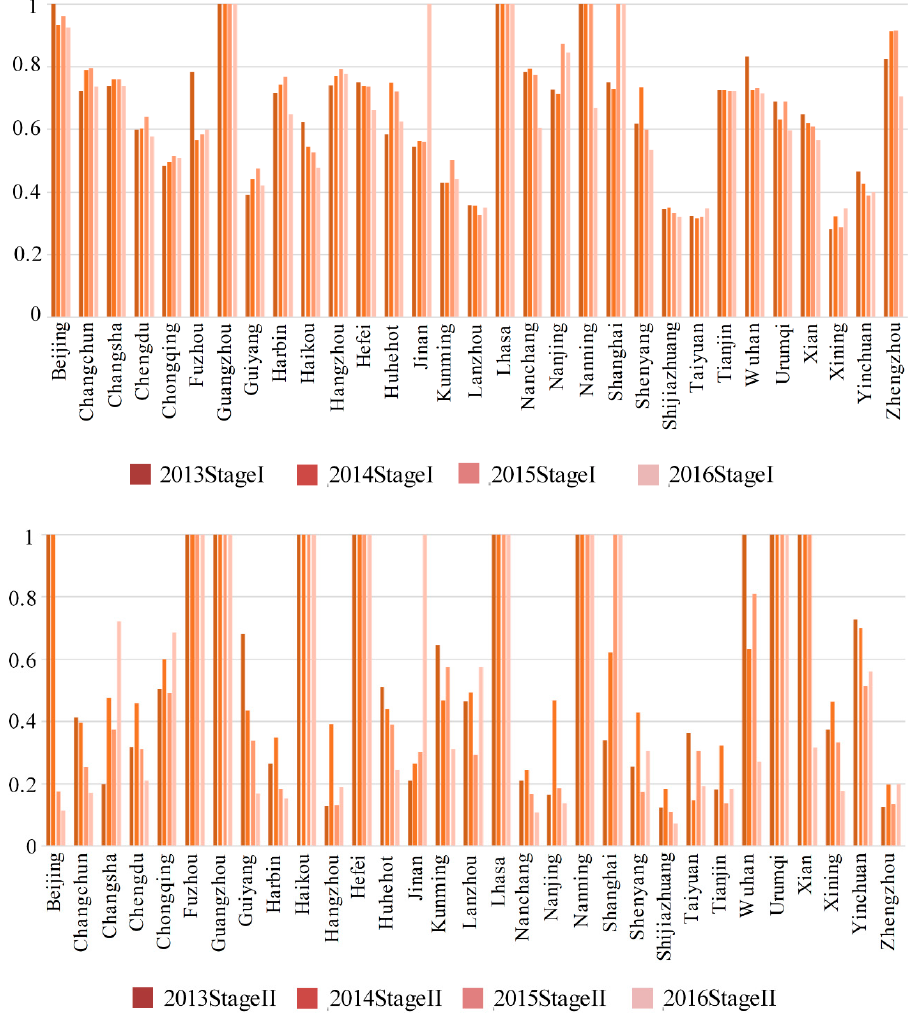
ffi ciency by city from Figure 4. Two stage efficiency by city from 2013–2016. Figure 4. Two stage e